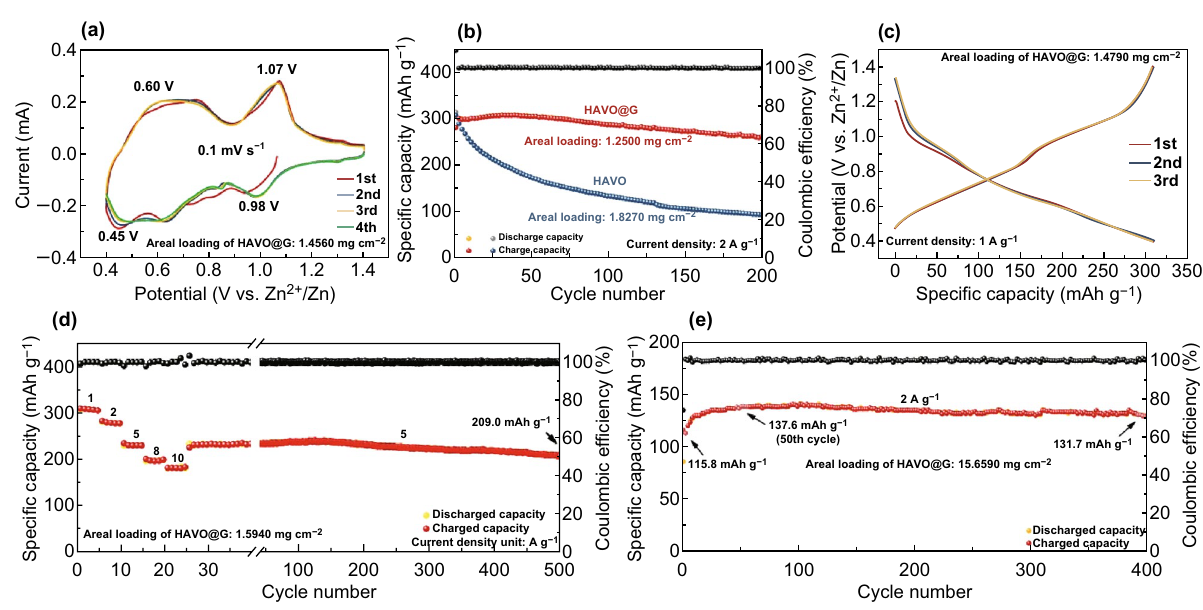
Fig. 2 a CV curves at a scan rate of 0.1 mV s −1 for HAVO@G. b Cycling performances at a current density of 2 A g −1 of HAVO and HAVO@G. c Galvanostatic charge–discharge curve at 1 A g −1 for HAVO@G. d Rate capability at 1–10 A g −1 of HAVO@G. e Cycling perfor- mance at 2 A g −1 of HAVO@G with high areal